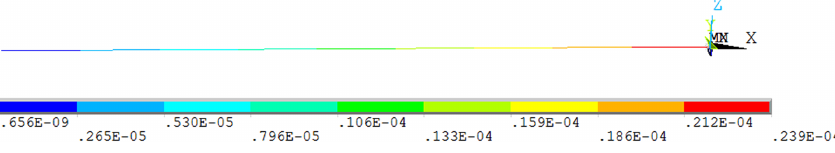
Figure 8. Color cloud picture of displacement.